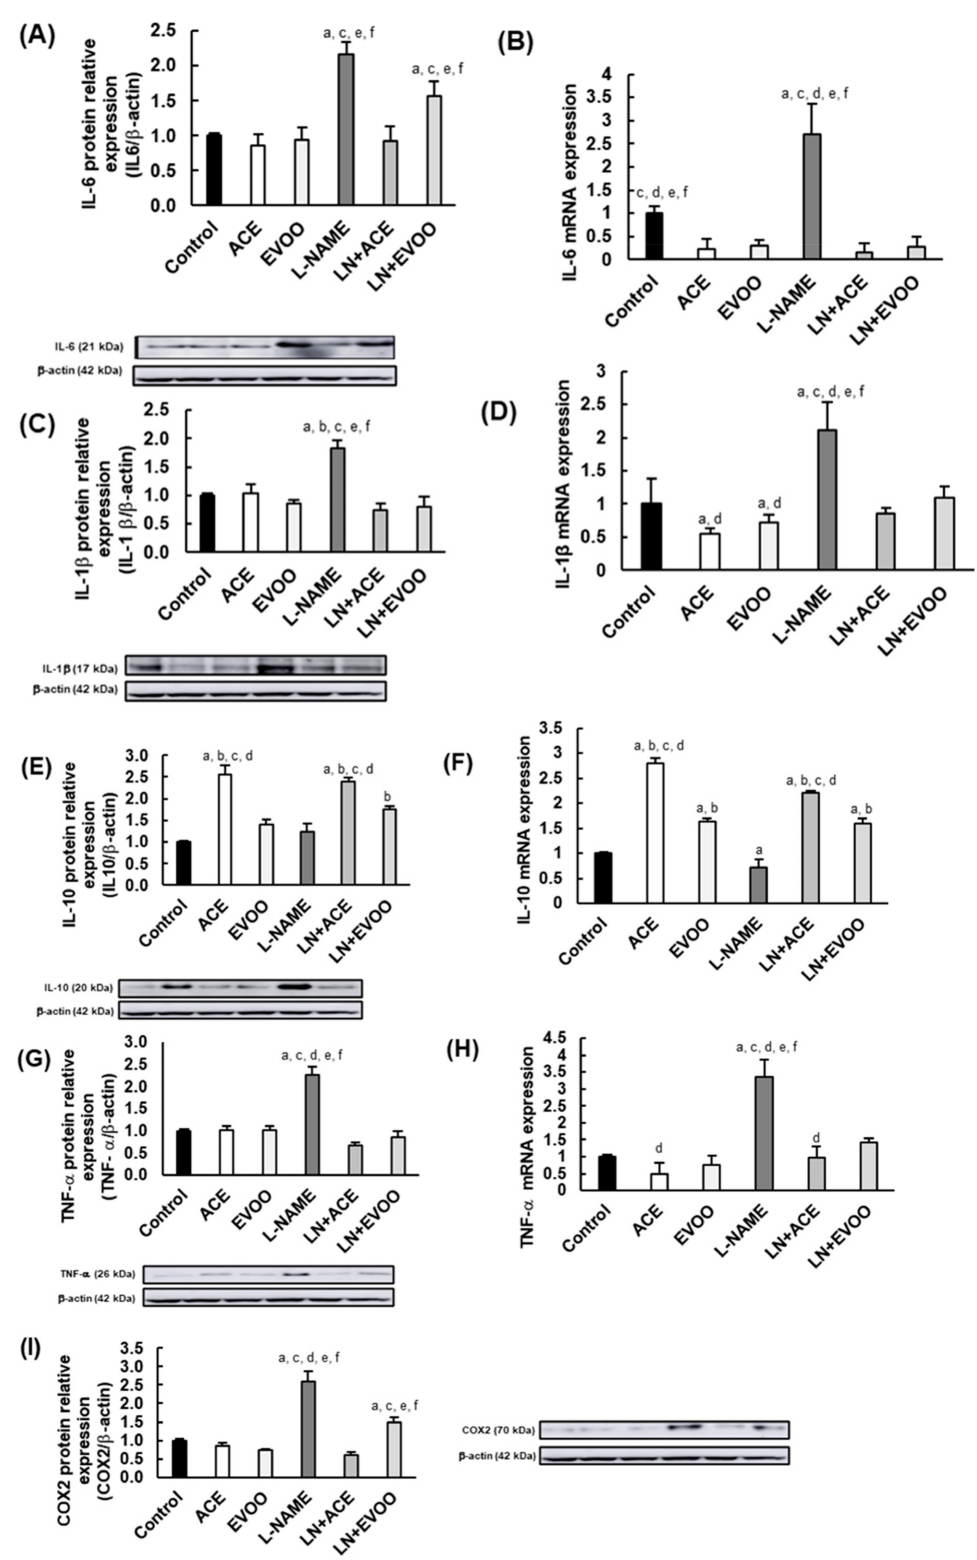
Figure 4. Protein and gene expression of inflammation-related biomarkers IL-6 ( A , B ), IL-1 β ( C , D ), IL-10 ( E , F ), TNF- α ( G , H ) and COX2 ( I ) in retina homogenates. Gene expression was quantified as relative to GAPDH in each corresponding group. Values are expressed as mean ± SEM of five animals per group: a p < 0.05 vs. Control; b p < 0.05 vs. L-NAME; c p < 0.05 vs. EVOO; d p < 0.05 vs. LN + EVOO; e p < 0.05 vs. ACE; f p < 0.05 vs. LN +